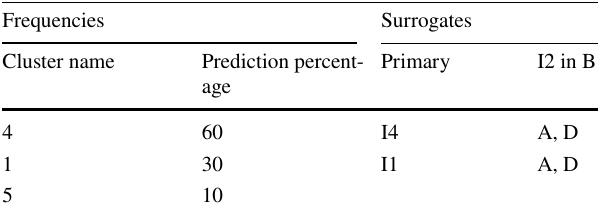
Table 11 Frequencies and surrogates data for A in I2 Table 12 Frequencies and surrogates data of B in I2